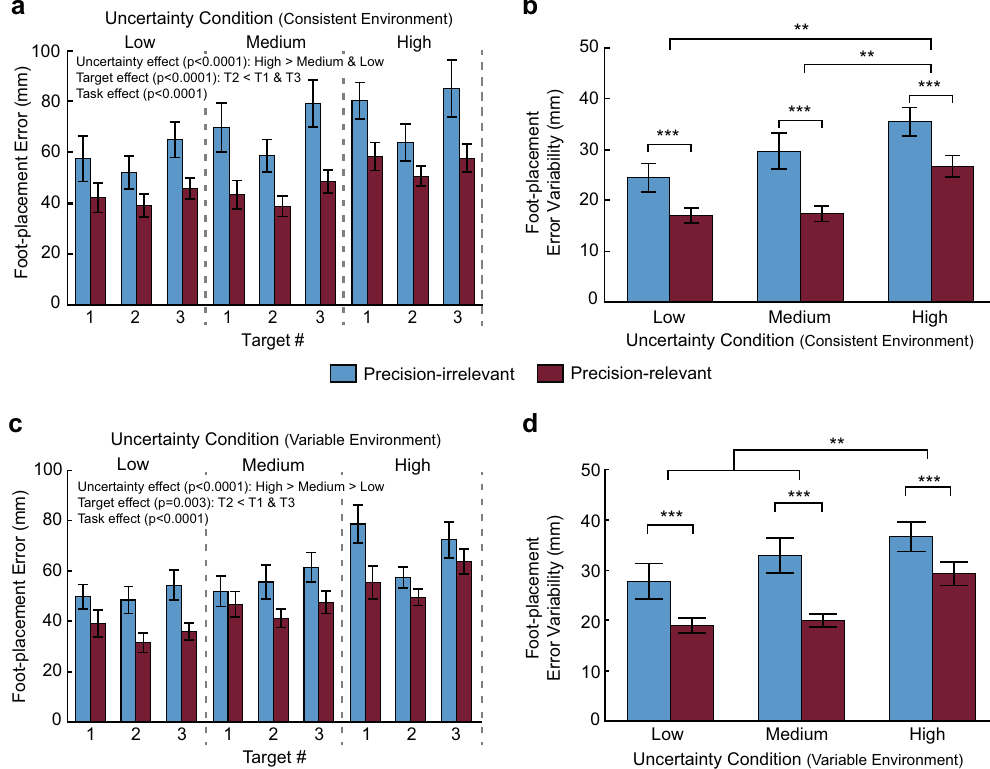
Figure 3. Foot-placement accuracy. Foot-placement error by target for the consistent environment ( a ) and variable environment ( c ) across uncertainty conditions and tasks is shown. Within-trial foot-placement error variability for the consistent environment ( b ) and between-trial foot-placement error variability for the variable environment ( d ) across uncertainty conditions and tasks are shown. Data are represented as mean ± SE. ** Indicates uncertainty conditions are significantly different from each other (uncertainty main effect: p < 0.05). *** Indicates tasks are significantly different from each other (task main effect: p <